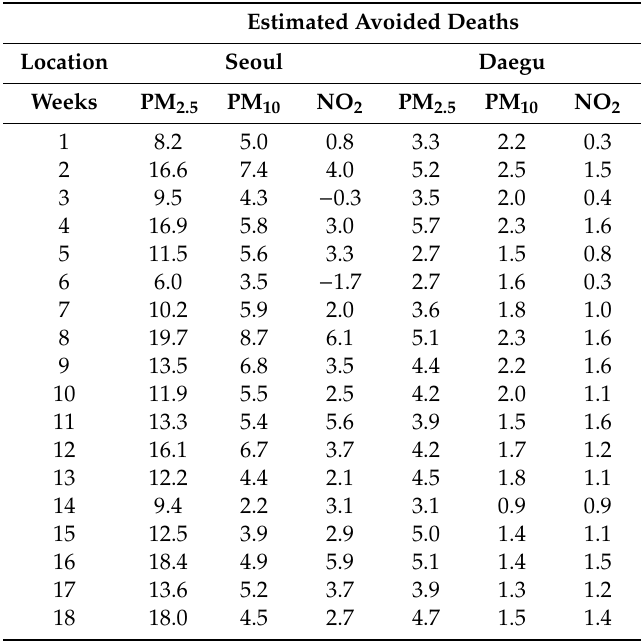
Table 2. Assessment of weekly avoided deaths due to reductions in PM 2.5 , PM 10 , and NO 2 . Estimated Avoided Deaths Location Seoul Daegu Weeks PM